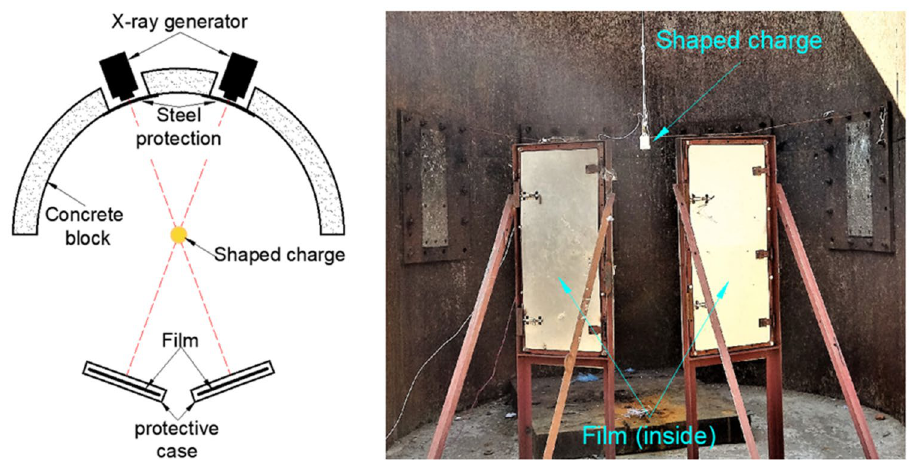
Figure 2. Schematic illustration of the X-ray